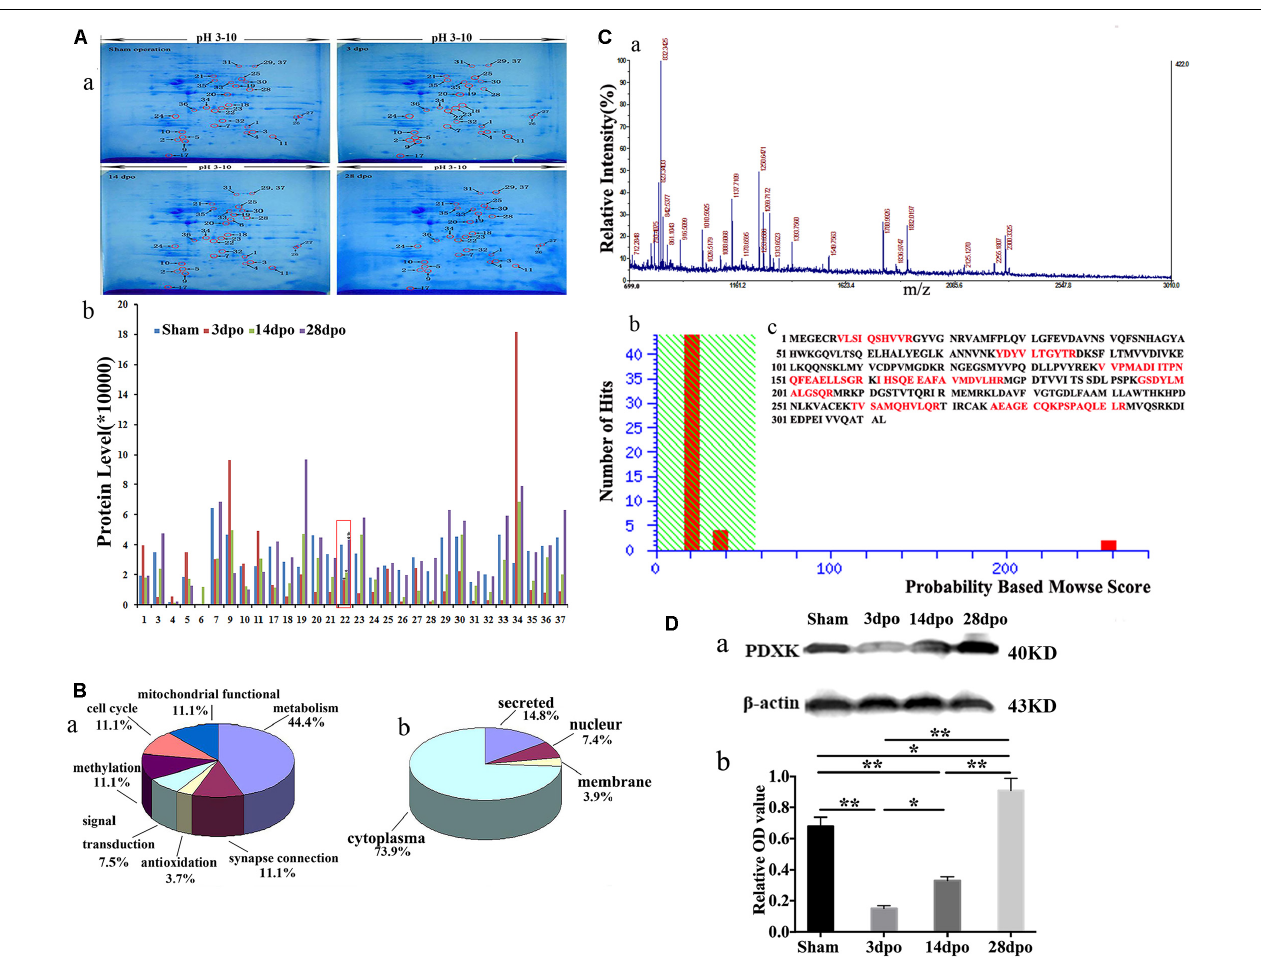
FIGURE 1 | Proteomic analysis in the cortex of spinal cord transection (SCT) rats and matrix-assisted laser desorption ionization-time of flight mass spectrometry (MALDI-TOF-MS) spectrum as well as the verification of PDXK. (A-a) Representative 2-DE maps of cortex in the sham, 3, 14, and 28 dpo groups were displayed in polyacrylamide gel with CBB G-250 staining. (A-b) Protein quantitative analysis for 30 differential spots.* > 1.5-fold change vs. sham group; # > 1.5-fold change vs. 3 dpo group. (B-a,b) Classification of proteins based on their functions and subcellular localization. (C-a) Primary mass spectrometry result of spot 22 (PDXK). (C-b) The results of probability-based Mowse score showed that the differential expression of protein is PDXK, where Mowse score is 258 ( > 56, P < 0.05). (C-c) The amino acid sequence of PDXK and matching peptides was exhibited in bold red with 31% of matching percentage. (D-a,b) The expression level of PDXK was tested by Western blot and normalized to β -actin by Image J. Data were presented as mean ± SD. * P < 0.05; ** P < 0.01. dpo, days post-operation; CBB, coomassie brilliant blue, PDXK, pyridoxal